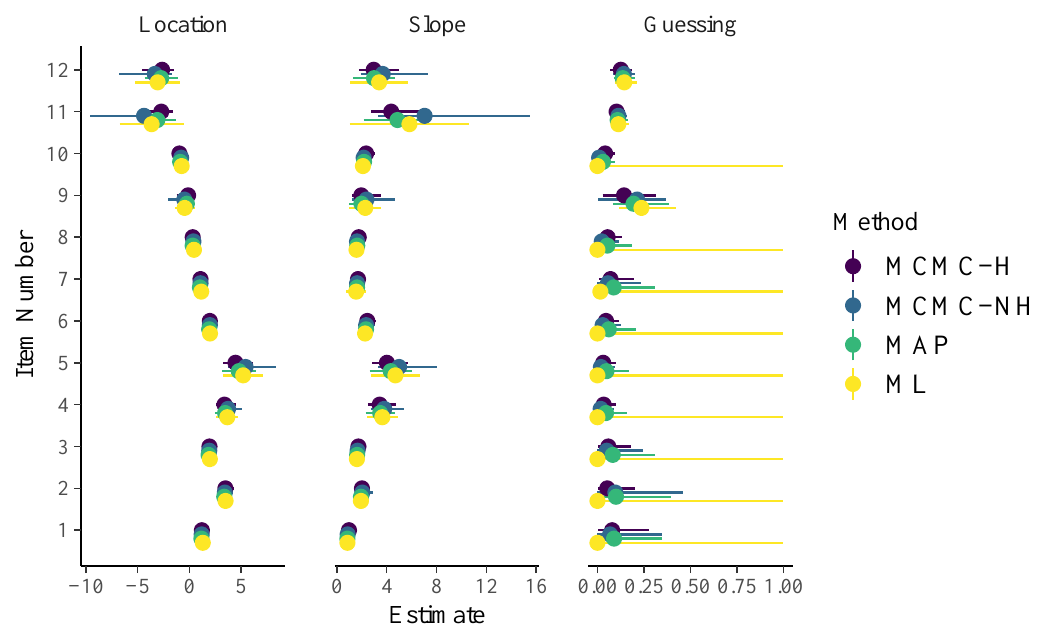
Figure 3. Item parameters of the 3PL model. Horizontal lines indicate 95% uncertainty